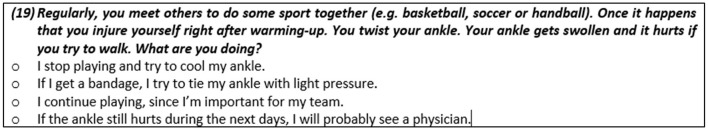
Example for a multiple choice item of the standardized paper and pencil test.